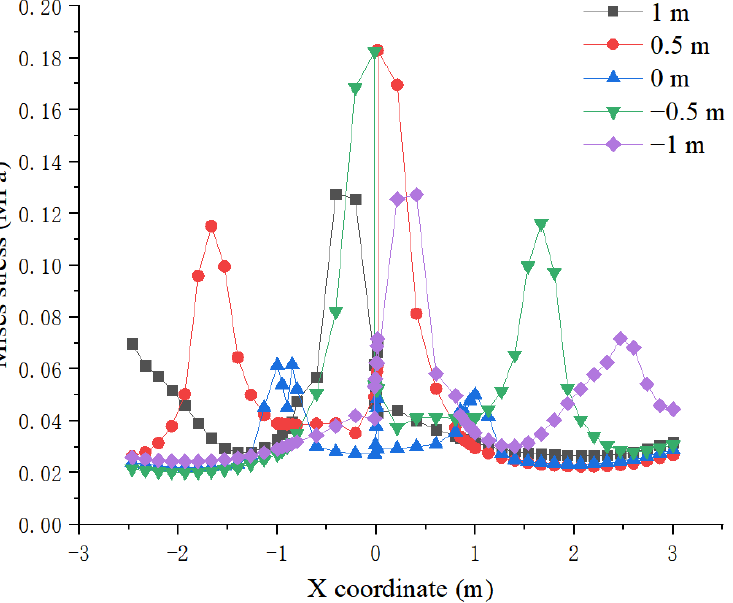
Figure 25. Mises stress distribution of the dam at the height of 14.625 m under different driving positions.